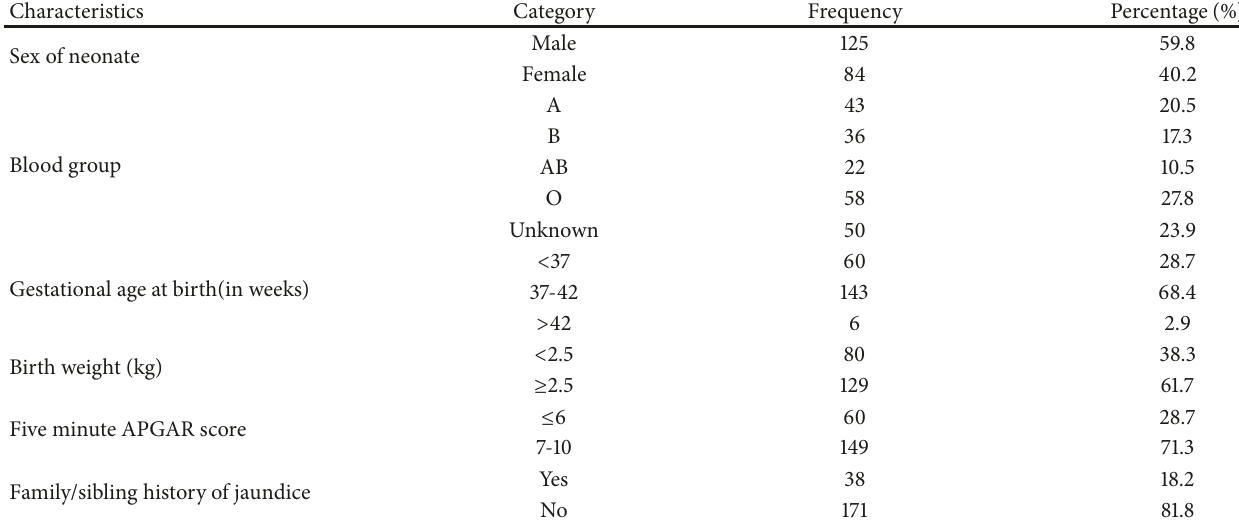
Table 2: Neonatal characteristic distribution among neonates admitted to neonatal intensive care unit of Mekelle city public hospitals, Northern Ethiopia,